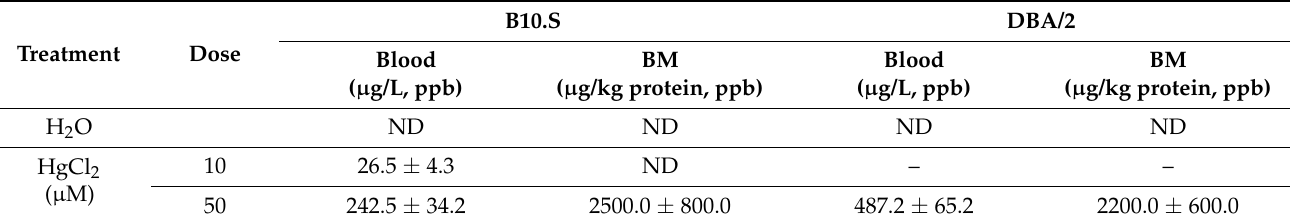
Table 3. Hg concentration (mean ± StD) in the blood and BM of